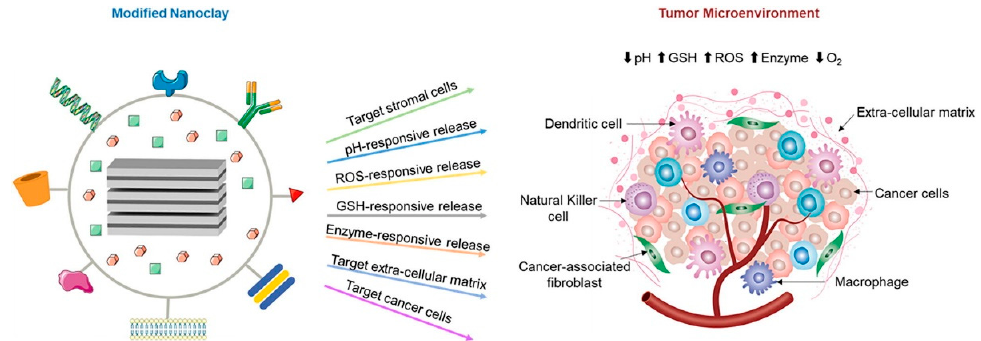
Figure 2. Schematic illustration of strategies used to expand the functions of nanoclays. The modified-nanoclays target the tumor microenvironment (TME), increasing the efficacy of cancer therapy. TME has been shown to have different characteristics from normal tissues, which can be vascular defects, higher expression of given enzymes, elevated glutathione (GSH), hydrogen ion, and reactive oxygen species (ROS) concentrations. Reprinted with permission from [9]. Copyright 2021 Elsevier B.V.